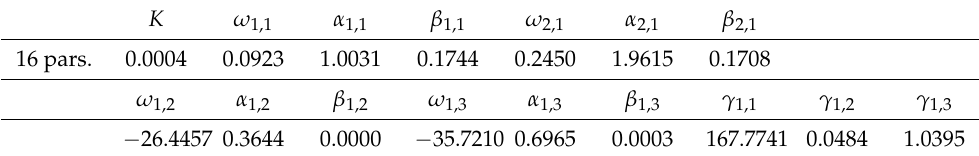
Figure 10. Comparison of the frequency responses of the fitted high-order ARX model and the complex-order model (second transfer function). Table 2. Parameters of the fitted 16-parameter complex-order model.